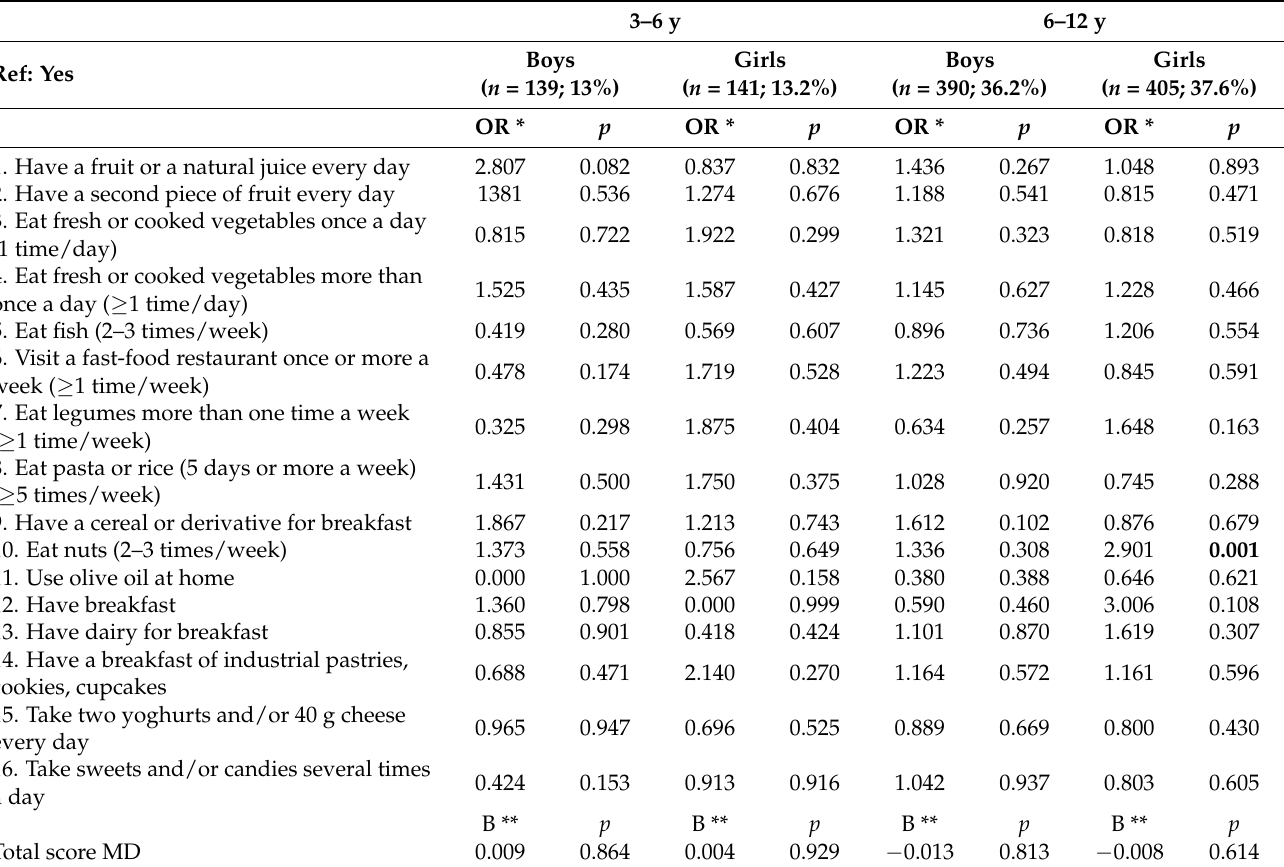
In Table 3, individual components of the Mediterranean diet adherence questionnaire were analysed. There was only an increased odds of having overweight/obesity when girls 6–12 y did not consume nuts regularly. Table 3. Logistic regression analysis between the different components of the Mediterranean diet adherence questionnaire and the probability of having overweight/obesity (odds ratios and p -values) ( n = 1075). 3–6 y 6–12 y